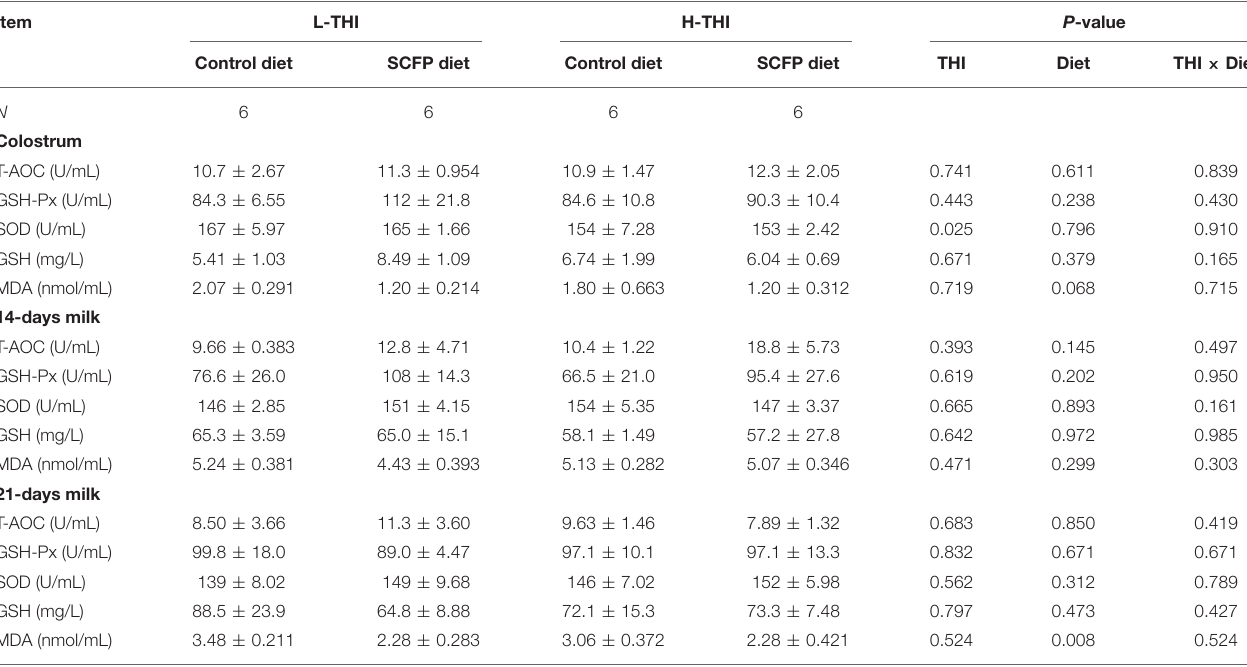
TABLE 7 | Effects of dietary supplementation of Saccharomyces cerevisiae fermentation product during late pregnancy and lactation on antioxidant status in colostrum and milk of sows in a subtropical climate (Mean ±